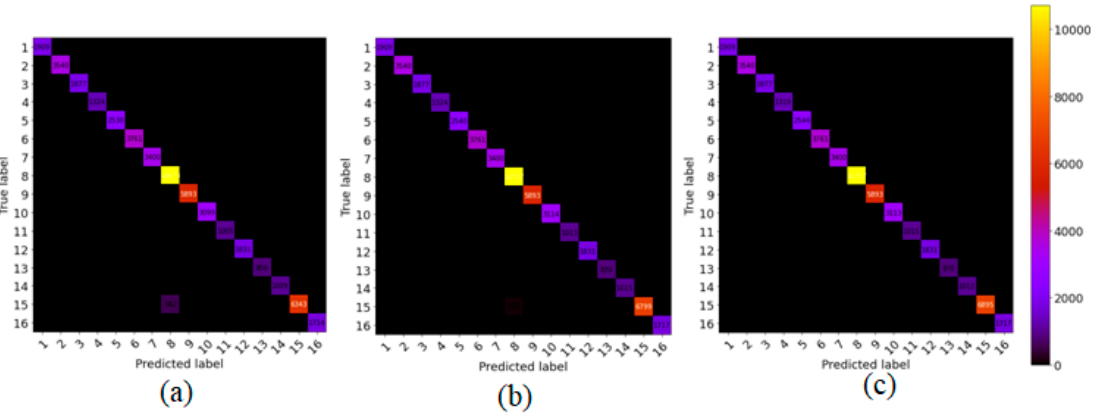
Figure 5. The confusion matrix for classification results of ( a ) SSRN, ( b ) HybridSN ( c ) GGBN over IP dataset.